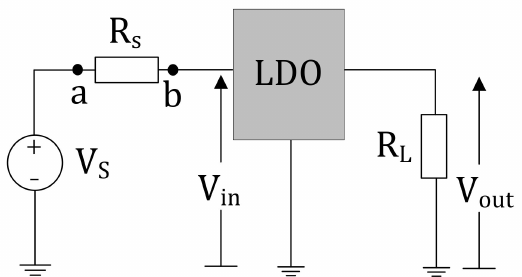
Figure 5. The arrangement in which a resistor is placed in series with the linear regulator to reduce the voltage headroom when the supply voltage is high.